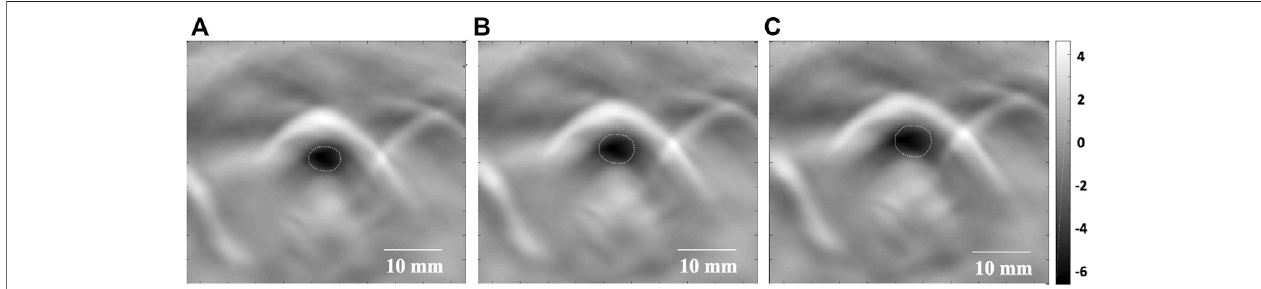
FIGURE2 | Real-time PATimagingofthe trachea at different phases ofarespiratory cycle. (A) Thesmallest tracheal CSA (whitecircle)at the end ofexhalation. (B) ThetrachealCSA (whitecircle)beginstoincrease asinhalationbegins. (C) Thetracheal CSA(whitecircle)increasesfurtherat theendofinhalation.CSA:cross-sectional area. Dotted line: tracheal lumen. Scale bars are 10 mm long.